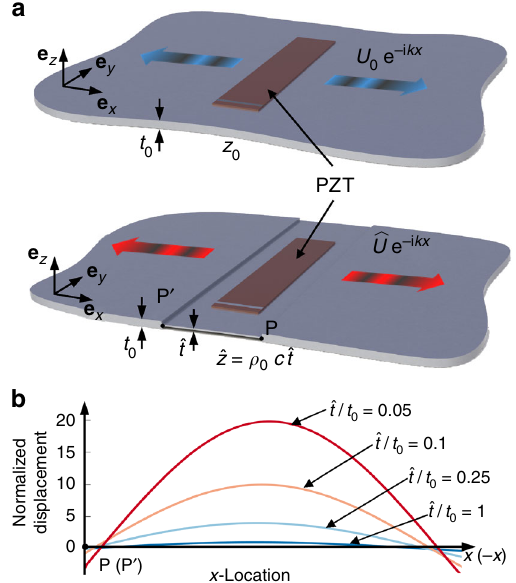
Fig. 1 The concept of lowered impedance for wave emission enhancement. a Thin plates of uniform and non-uniform thicknesses carrying plane longitudinal waves. The piezoceramic patch transducers (PZT) are installed to excite the S 0 Lamb waves in the plates simulating the longitudinal waves in a bar. b The ampli fi cation effects of the non-uniformity (expressed in terms of ^ t = t 0 , where ^ t is reduced thickness of the transducer installed zone and t 0 nominal thickness) on the magnitude of the generated displacement fi